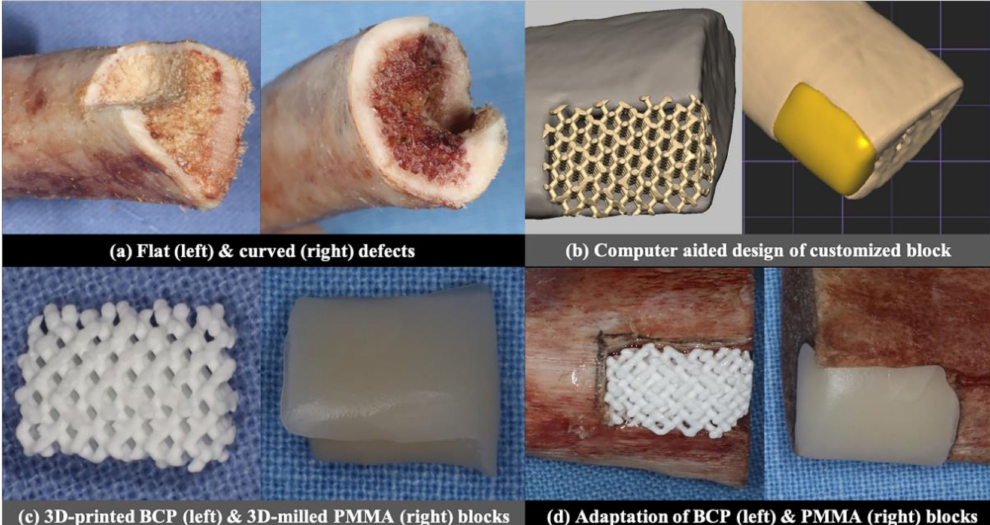
Figure 1. Summary of the experimental